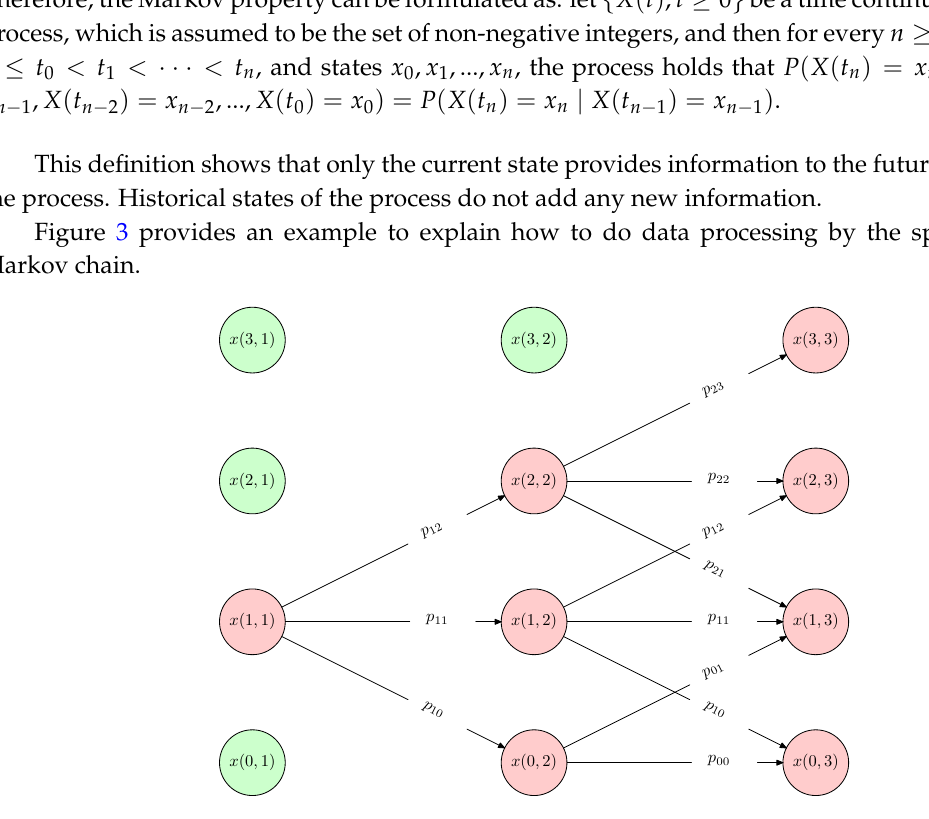
Figure 3. A spatio-temporal Markov chain for the processes of industrial